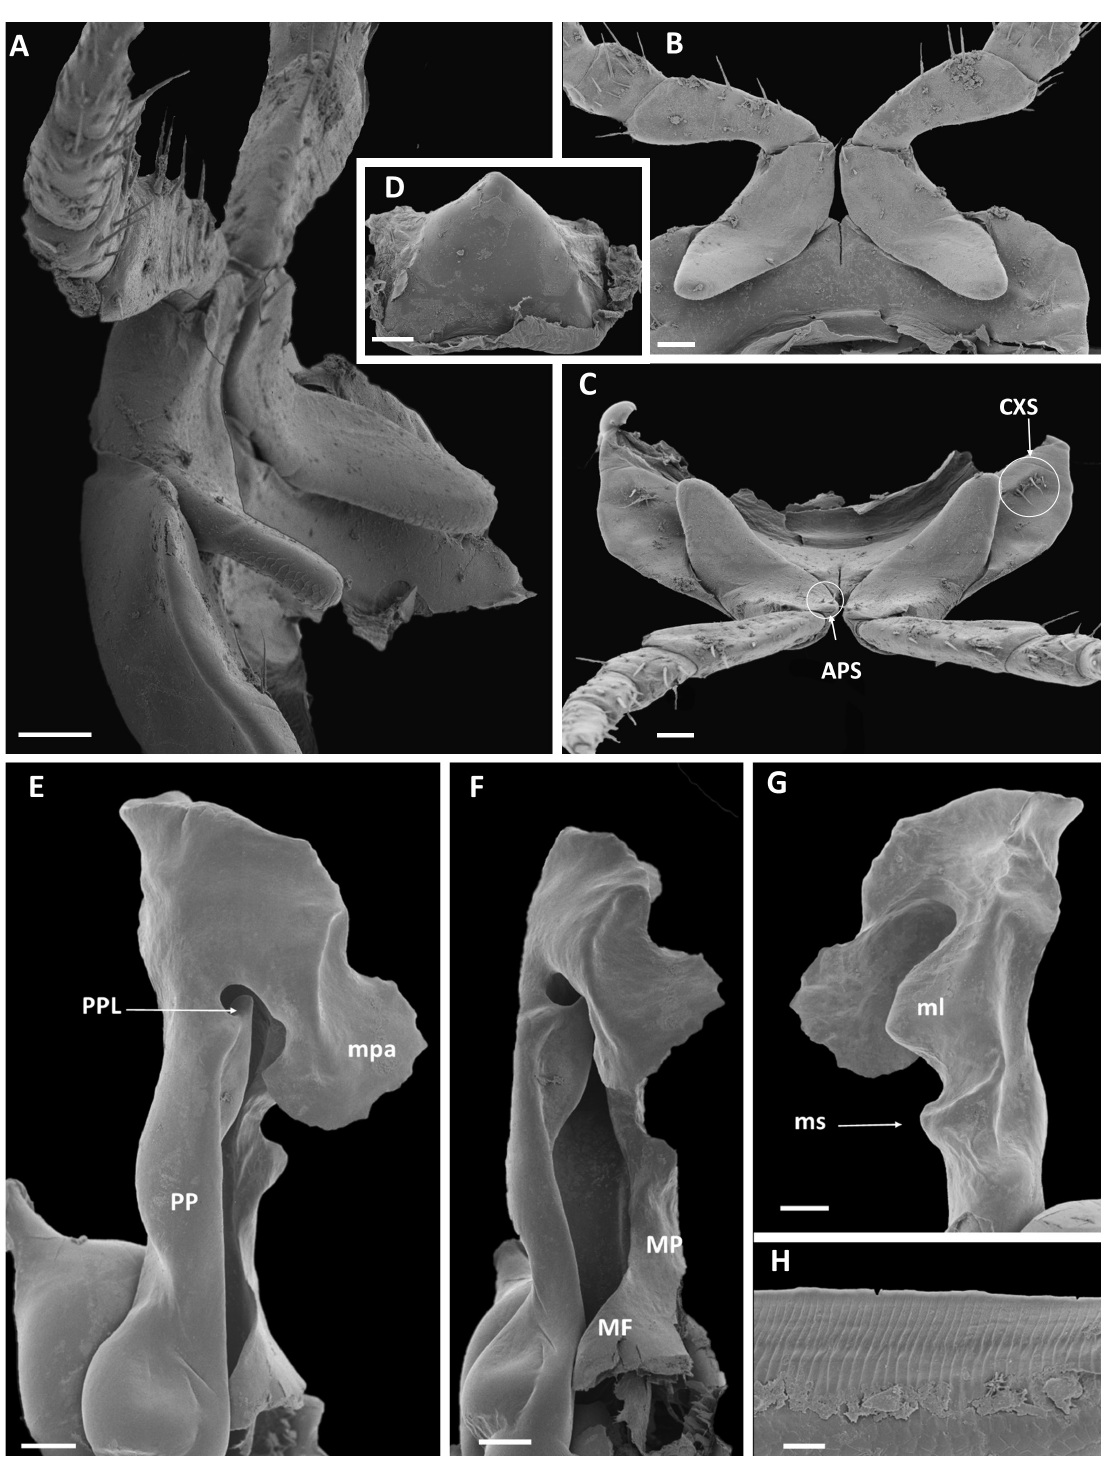
Fig. 29. Chaleponcus schioetzae sp. nov., holotype, ♂ (NHMD 621725). A–C . First pair of legs. A. Sublateral view. B. Anterior view. C. Ventral view. D . Sternum 9. E–G . Left gonopod coxa E. Anterior view. F. Mesal view. G. Lateral view. H . Midbody dorsal limbus. Abbreviations: APS = mesapical prefemoral setae; CXS = coxosternal setae; MF = metaplical flange; ml = metaplical lobe; mpa = metaplical palette; ms = metaplical shelf; PP = proplica; PPL = proplical lobe. Scale bars: A–G = 0.1 mm; H = 0.02